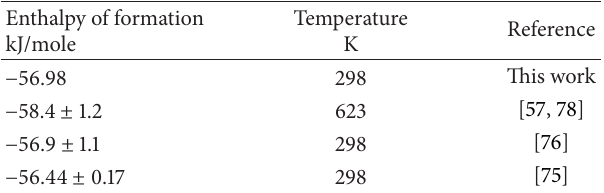
Table 3: Enthalpy of formation of the NaH